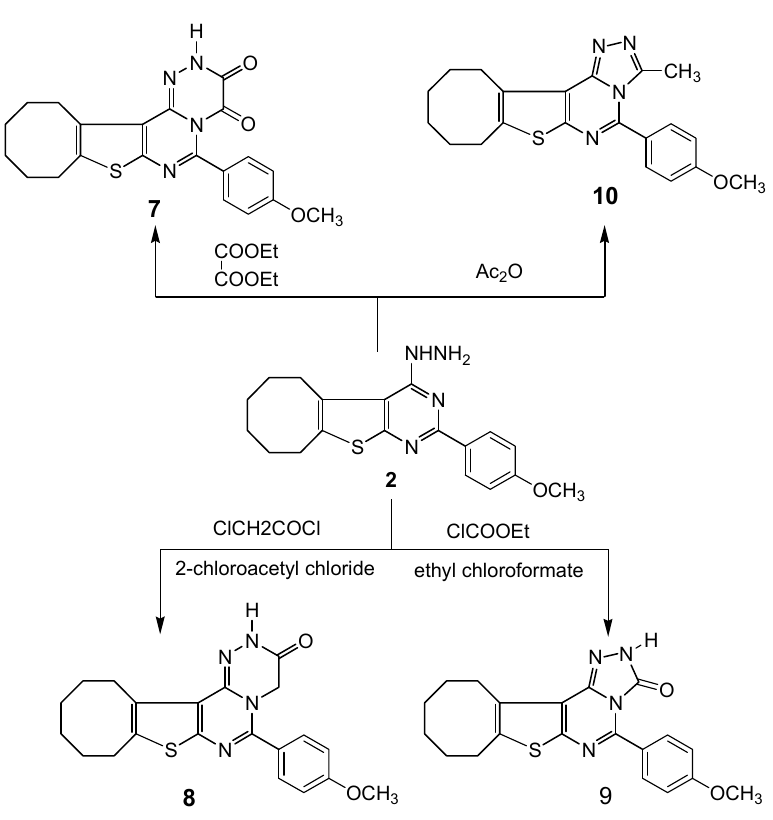
Scheme 2. Synthetic route for compounds 7 – 10